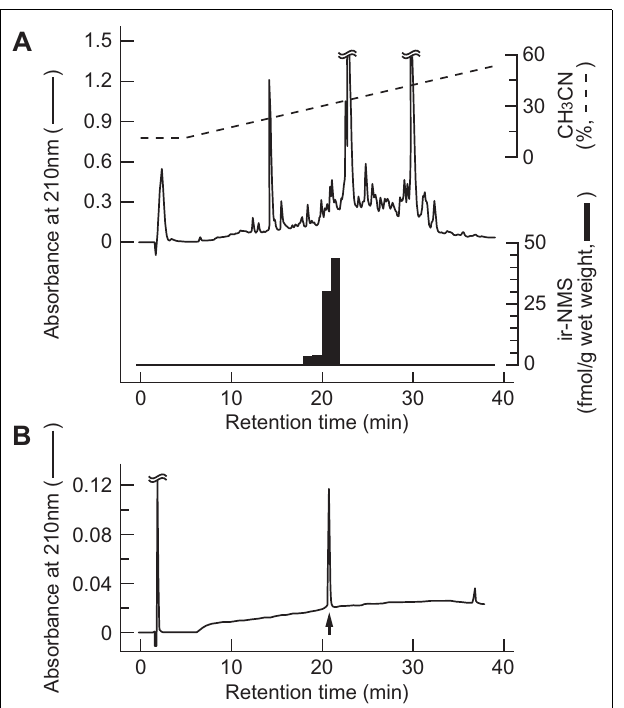
FIGURE 2 | Representative reversed-phase high performance liquid chromatography (RP-HPLC) profile of neuromedin S (NMS) immunoreactivity in rat brain. Peptide extract (equivalent to 1.2 g wet weight) from rat whole brain (A) and synthetic rat NMS (B) were applied to RP-HPLC under the same conditions. Black bars indicate immunoreactive NMS detected by radioimmunoassay (A) . Elution position of rat NMS is indicated by the arrow (B) .